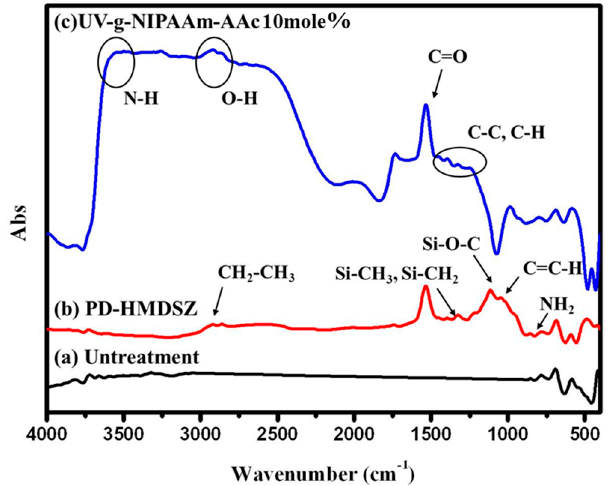
Figure 4. Fourier Transformation Infrared (FTIR) spectra of ( a ) un-modified, ( b ) HMDSZ-treated, and ( c ) NIPAAm/AAc hydrogel-grafted stainless steel specimens.